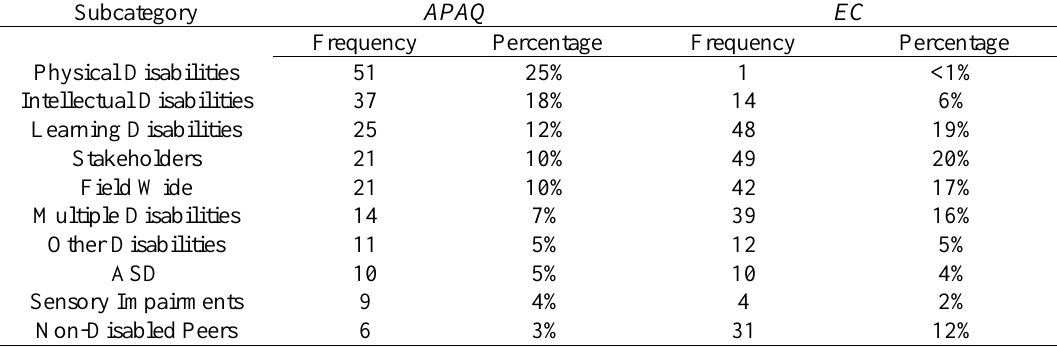
Table 2. Frequency and percentage of population of interest across journals. Subcategory APAQ